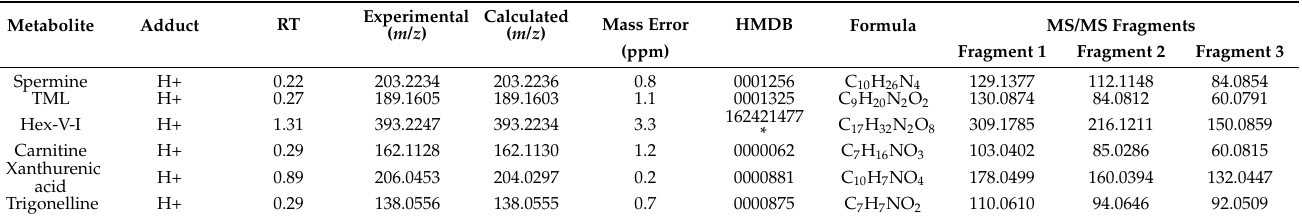
Figure 2. ( A ) Metabolite levels in mouse urine after exposure to the reference dose rate (0.7 Gy/min) or very high-dose rate (VHDR) (7 Gy/sec) at 1 and 7 days (d). These metabolites have been identified in previous radiation experiments and were used to determine the area under the receiver operating characteristic curves (AUROC). ( B ) ROC curves at 1 d (N6,N6,N6-trimethyllysine (TML), carnitine, Hex-V-I) at 7 d (trigonelline, carnitine, Hex-V-I, spermine) show excellent to good sensitivity and specificity irrespective of dose rate. (* p < 0.05, ** p < 0.01, *** p < 0.001 determined by a one-way ANOVA and a Dunnett’s multiple comparison test with p values corrected for multiple comparisons of post-irradiation samples to the control, Means ± S.E.; AUROC classification: excellent ≥ 0.9, good ≥ 0.8). Table 1. Validated urinary metabolites that significantly changed in mice exposed to reference dose rates (0.7 Gy/min) and very high-dose rates (7 Gy/sec).